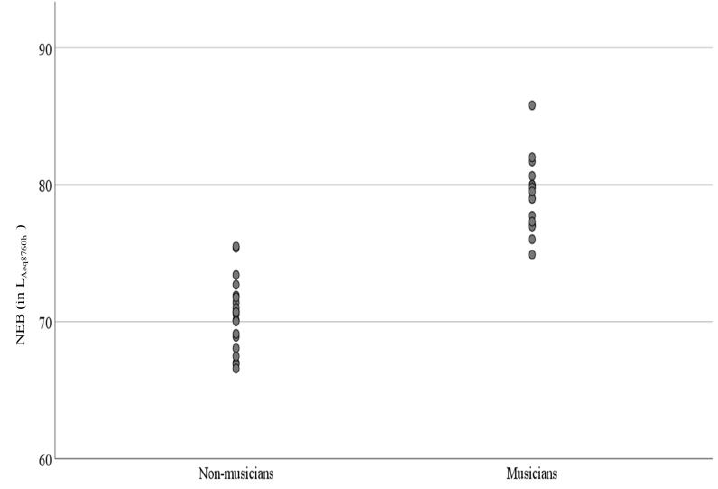
Figure 2. Simple scatter plot of NEB as a function of groups.